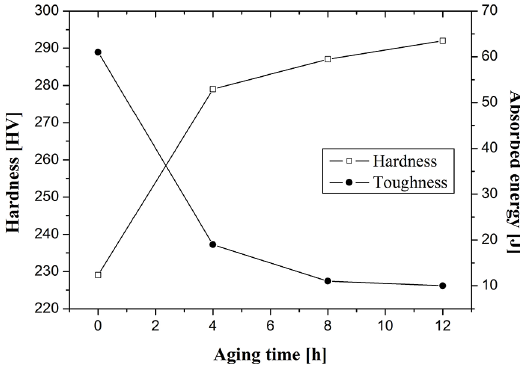
Figure 2. Curves of hardness and toughness as function of aging time at 475 o